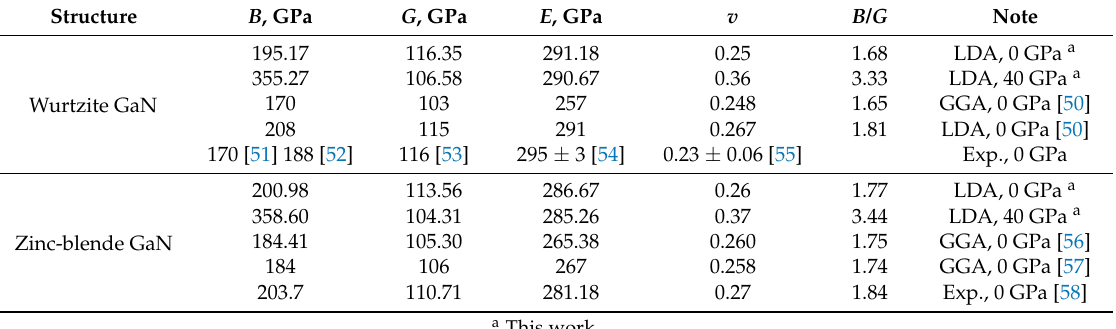
Table 3. Mechanical properties of GaN polycrystals.